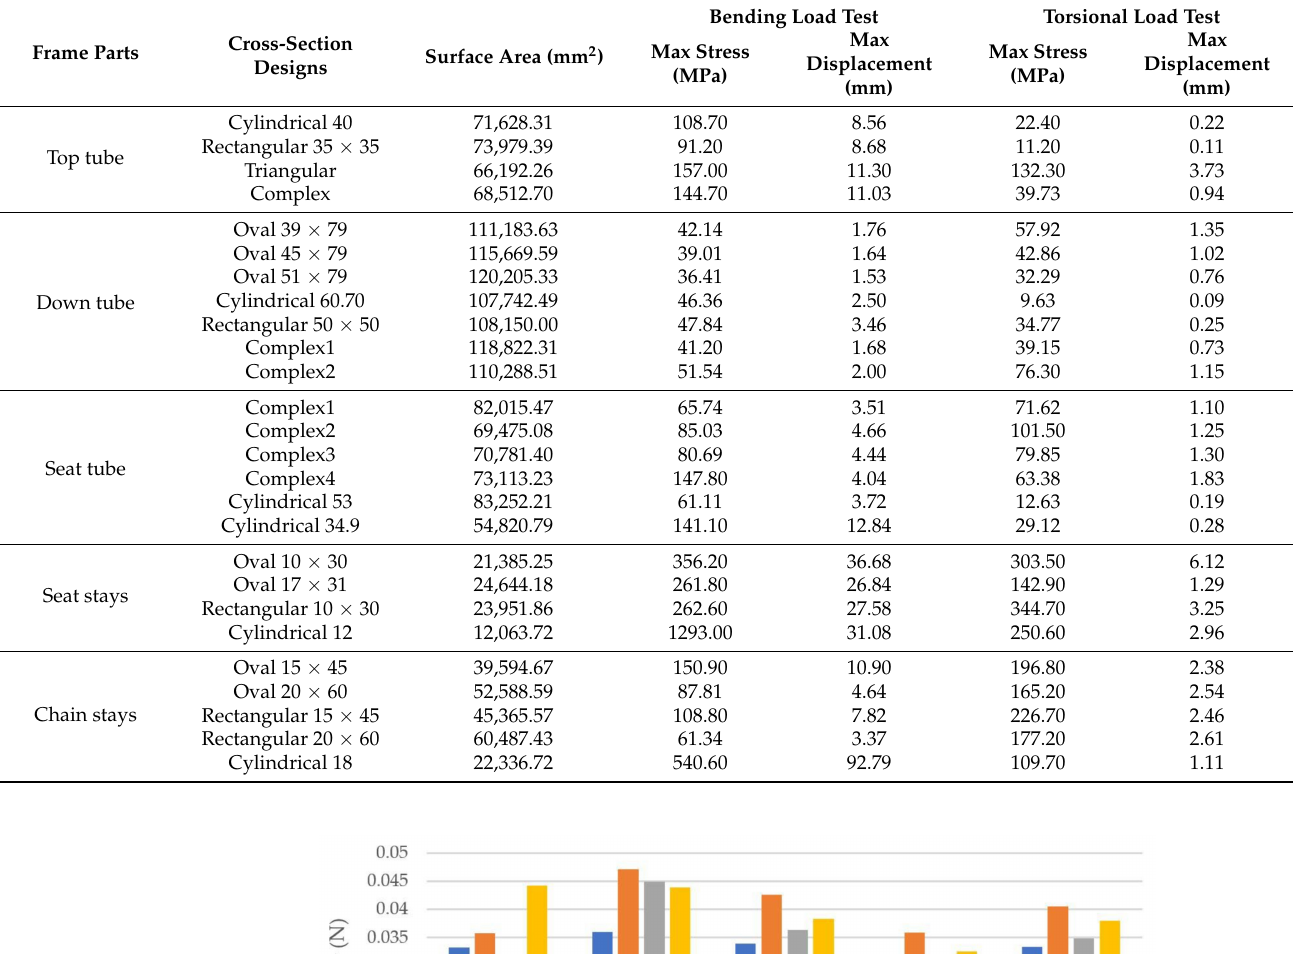
Table 14. Static analysis of all tubes under bending and torsional loads.